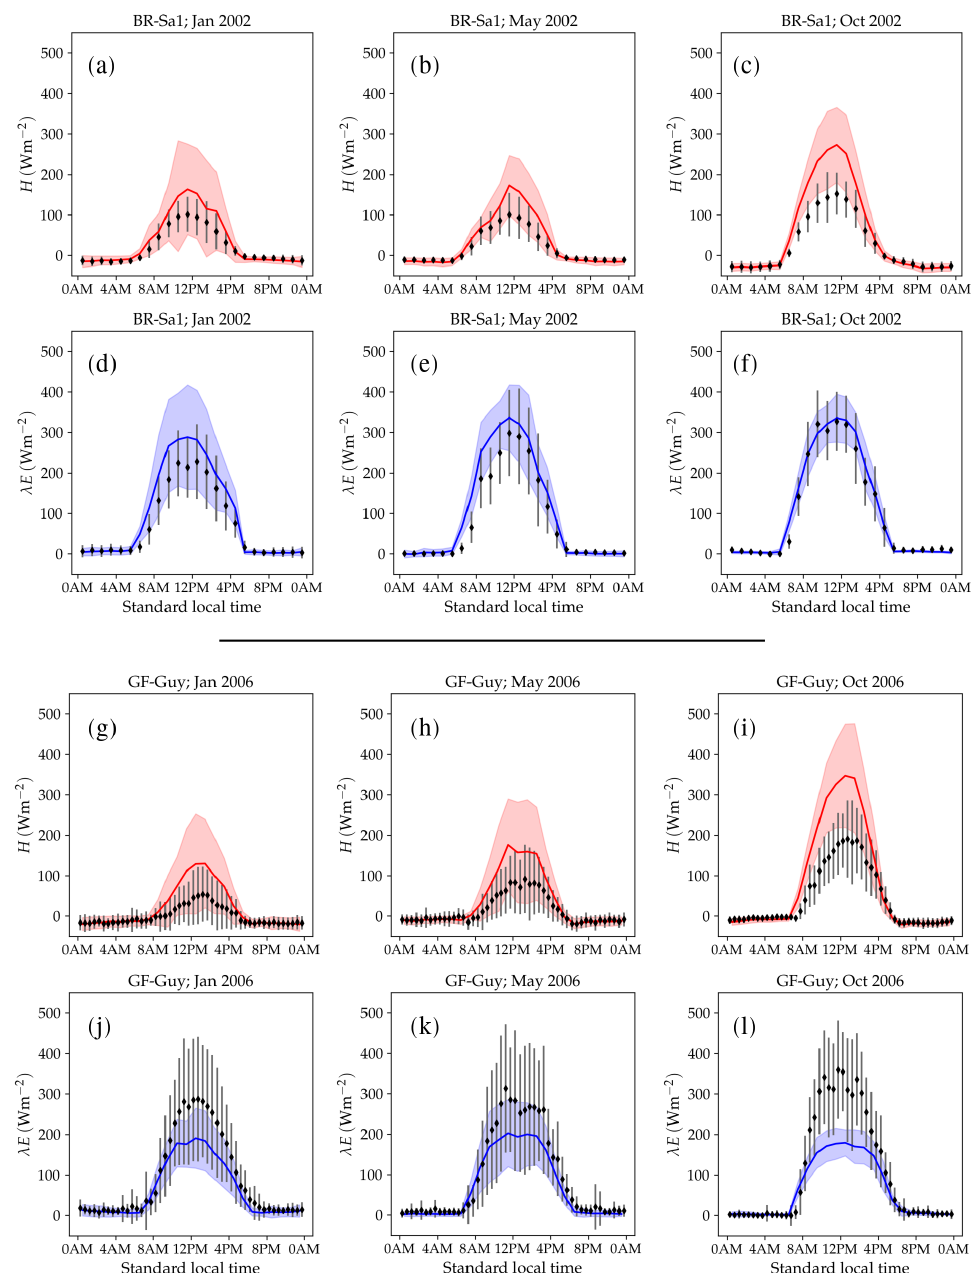
Figure 12. Monthly-averaged diurnal cycle of sensible and latent heat flux at the BR-Sa1 ( panels a–f) and GF-Guy ( panels g–l) sites in selected months. The red and blue lines represent simulated sensible and latent heat fluxes, respectively. The shaded areas around each curve delimit 1 standard deviation above and below it. The symbols represent monthly-averaged fluxes. The error bars indicate a ± 1 σ deviation from the observed